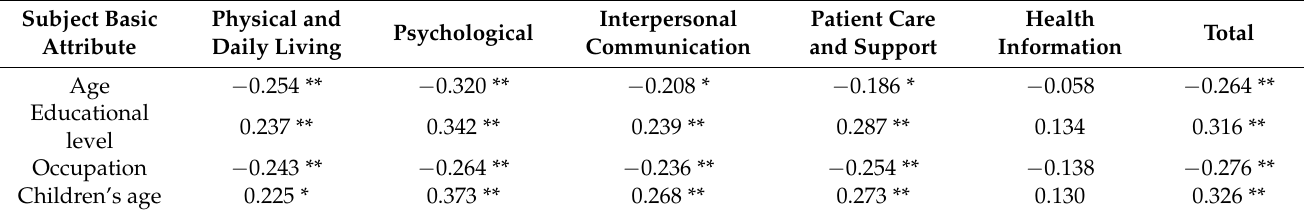
Table 3. Correlation between subjects’ basic attributes and their unmet care needs.